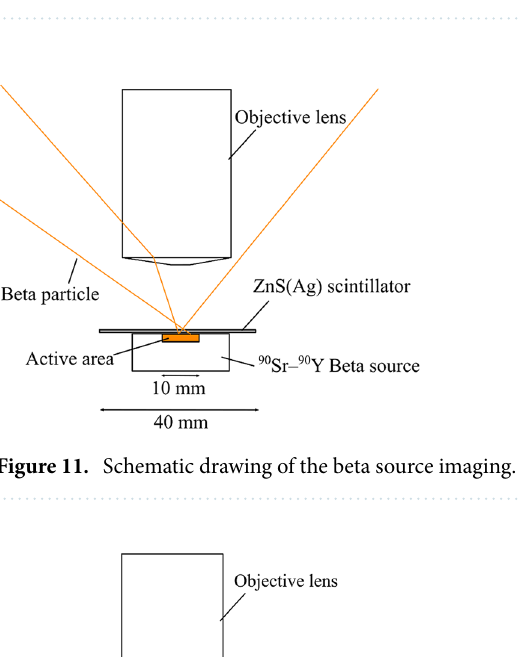
Figure 10. Schematic drawing of the alpha source imaging.